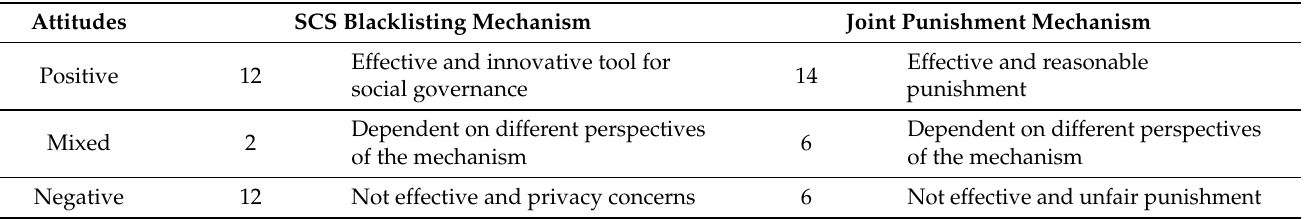
Table 5. The public’s perception of the punishment on “Lao Lai”. The table lists the most frequently mentioned points of